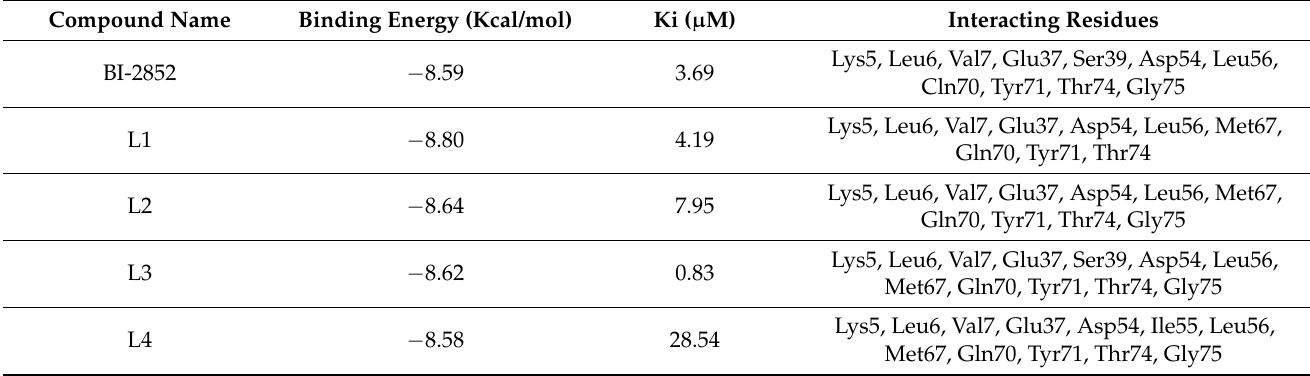
Table 3. Binding energies, inhibitory constant, and interacting residues of 4 leads.